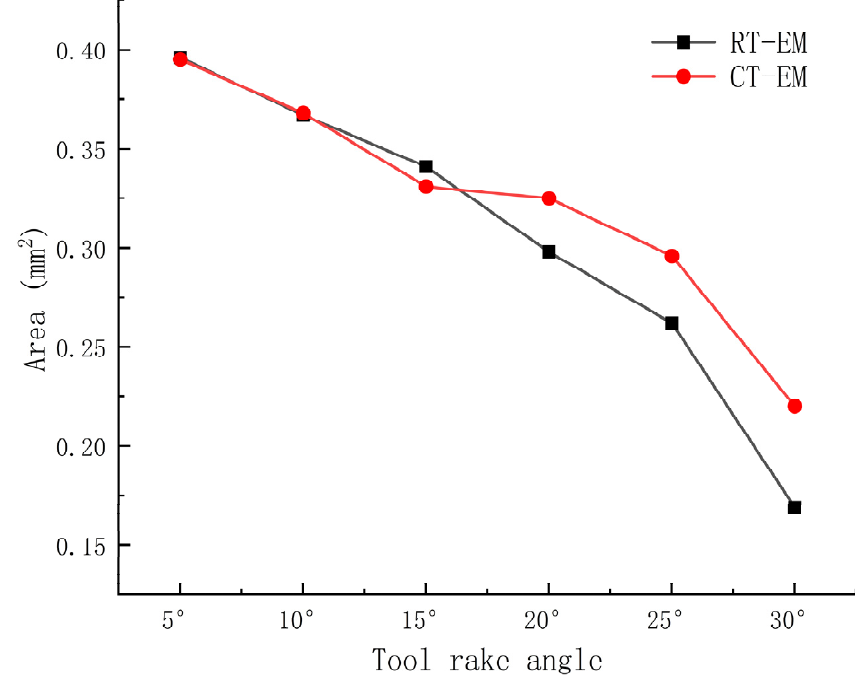
Figure 15. Cross-sectional area of the micro-grooved fins.